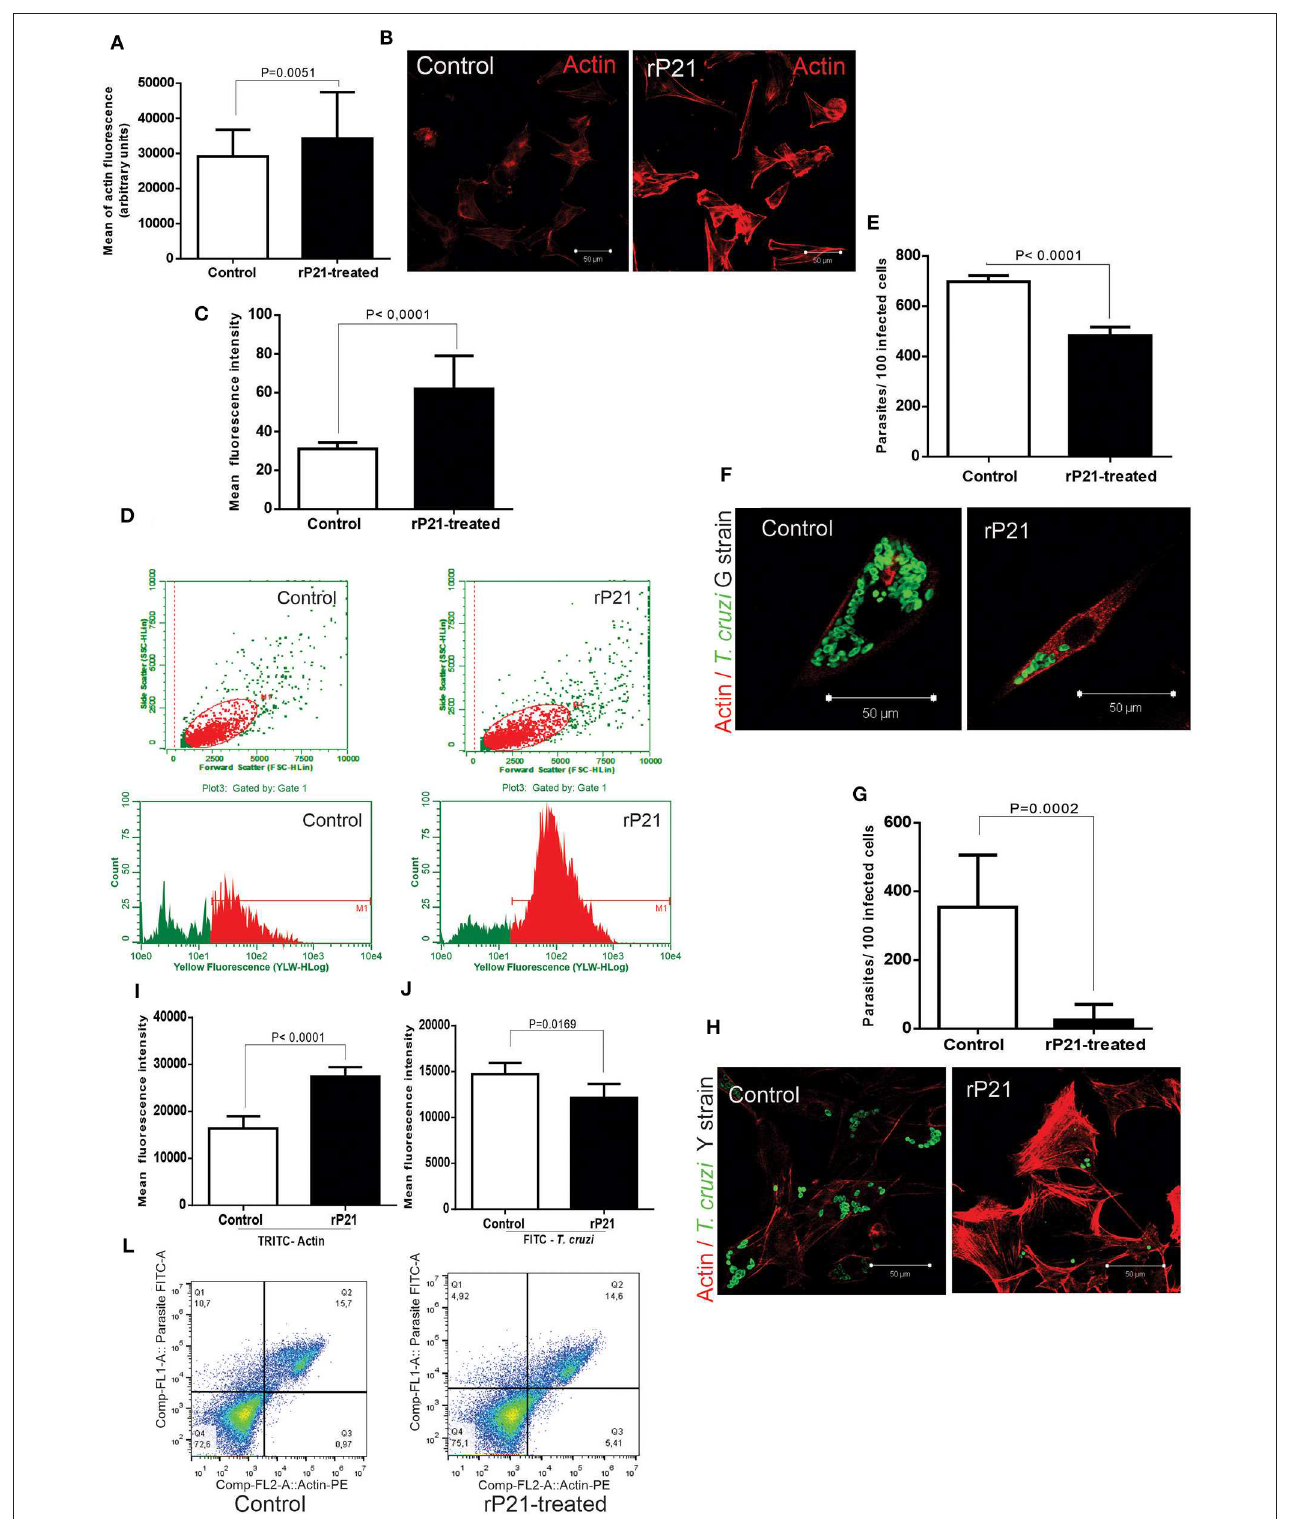
FIGURE 1 | rP21 enhances actin polymerization of C2C12 myoblasts and impairs T. cruzi intracellular replication. (A) rP21 induces actin polymerization in C2C12 cells after 96h treatment. F-actin is stained with TRITC-phalloidin (red). (B) Representative images of F-actin staining are shown. (C,D) Flow cytometry analysis